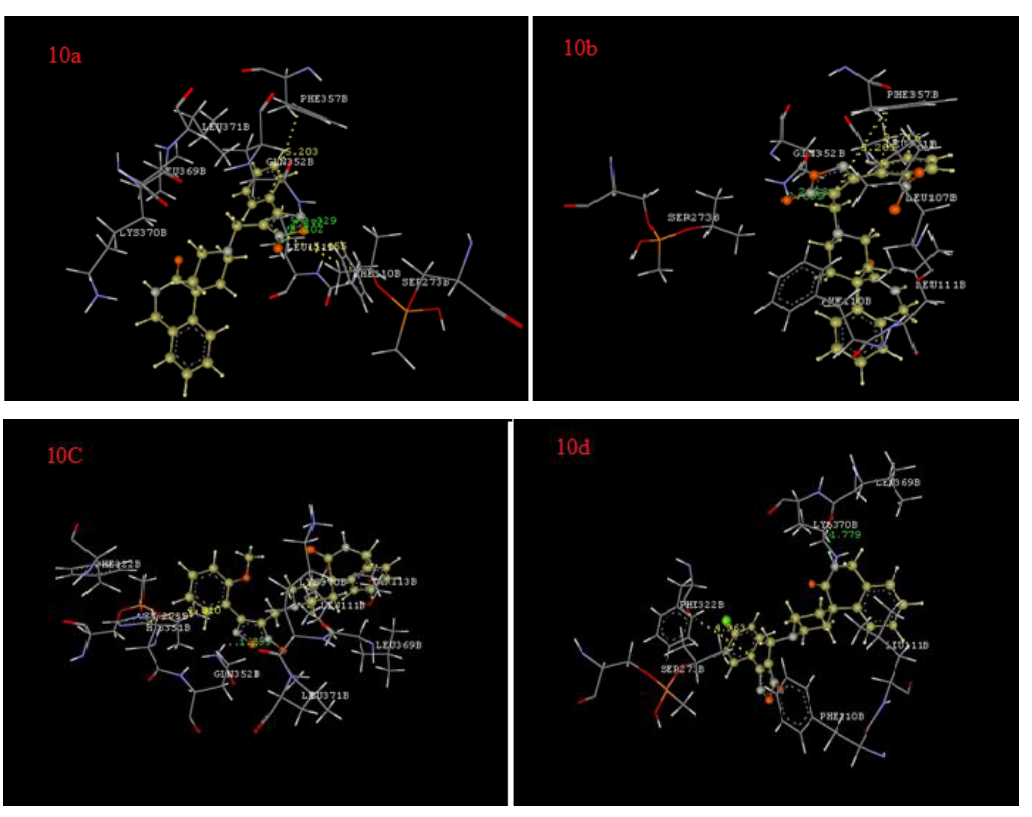
Table 2. Docking results.